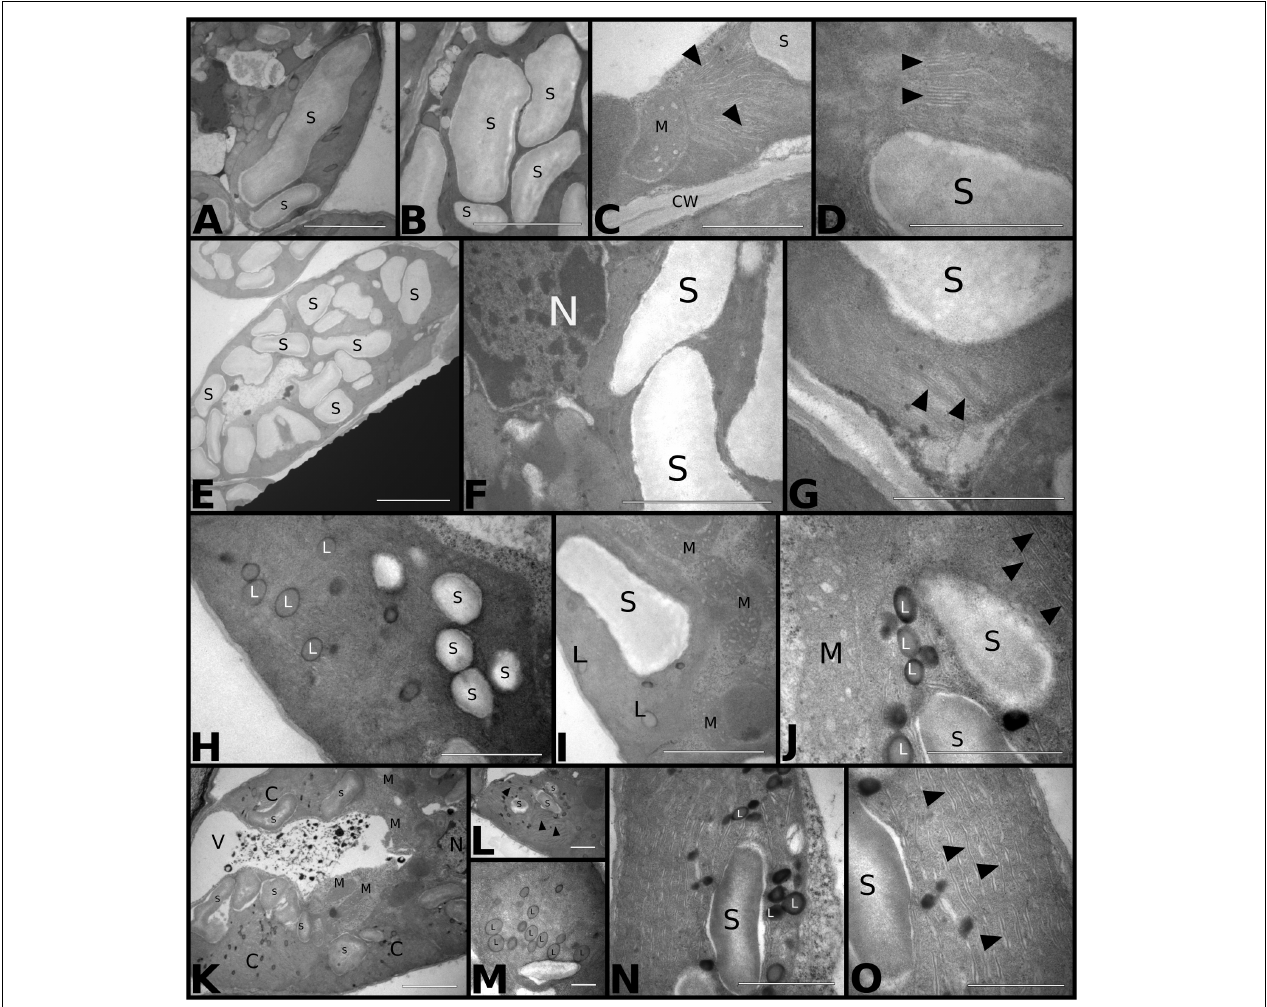
FIGURE 6 | Transmission electron micrograph of S. capitata leaves grown under different levels of [CO 2 ] and temperature at 66th day of experiment. (A–D) aCO 2 aT samples. (A,B) Longitudinal section of chloroplast showing large and numerous starch grains. Scale bar of 10 µ m in panels (A,B) . (C) Longitudinal section of the terminal portion of a chloroplast associated with mitochondria. Arrowheads show intact thylakoid membranes. Scale bar 3 µ m. (D) Details of thylakoid membranes of an intact chloroplast (arrowhead). Scale bar 2 µ m. (E–G) eCO 2 aT samples. (E) Overview of a chloroplast in longitudinal section showing a large number of starch grains. Scale bar 10 µ m. (F) Enlarged cell. Scale bar 4 µ m. (G) Details of a chloroplast showing the integrity of thylakoid membranes (arrowhead). Scale bar 3 µ m. (H–J) aCO 2 eT samples (H) Overview of a chloroplast from leaf mesophyll with a reduced number and size of starch grains and the presence of plastoglobuli in the stroma of chloroplast. Scale bar 3 µ m. (I,J) Detail of chloroplasts with a greater association with mitochondria. (J) Evidence that the internal membranes are less organized in the thylakoid (arrowhead). Scale bars 3 µ m in (I) and 2 µ m in (J) . (K–O) eCO 2 eT samples. (K) Overview of the mesophyll cell with chloroplasts in association with mitochondria and vacuole with presence of electrodense amorphous material. Scale bar 5 µ m. (L) Detail of a chloroplast in longitudinal section. Arrowhead – internal membranes of chloroplasts. Scale bars 2 µ m. (M) Detail of chloroplasts in cross section showing the large number of plastoglobuli in the stroma. Scale bar 2 µ m. (N,O) Details of chloroplasts showing plastoglobuli, starch grains, and internal membranes not associated in thylakoids (arrowhead). Scale bar 3 µ m in N and O. Abbreviations: S, starch grain; M, mitochondria; CW, cell wall; N, nucleus; L, plastoglobuli; C, chloroplasts; V,